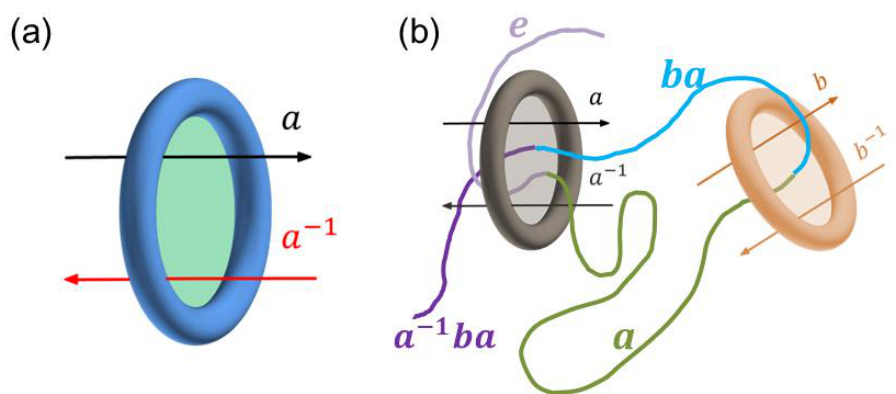
Figure 1. ( a ) In the superspace approach of 𝑛 ring-shaped obstacles, the subspaces can be connected with a ‘portal gate’, which is actually the circular plane (green) of the ring. Crossing the gate from left to right, in this example, corresponds to a generator 𝑎 of the 𝑛 -generator free group, which is also a group element of this group. ( b ) A typical example of the entangling mode corresponding to the group element 𝑎 −1 𝑏𝑎 . Note that the light-purple chain segment is in the identity subspace 𝑒 , the green chain segment is in the subspace 𝑎 , the light-blue is in 𝑏𝑎 , and the purple is in 𝑎 −1 𝑏𝑎 . Accordingly, the original propagator 𝑞(𝒓, 𝑠) will be expanded to an infinite number of propagators denoted by 𝑞 𝑔 (𝒓, 𝑠) with 𝑔 a group element of the n-generator free group corresponding to an entangling mode. When 𝒓 is not closed to the portal gate, the func- tion 𝑞 𝑔 (𝒓, 𝑠) only propagates within the subspace 𝑔 according to the diffusion equation,